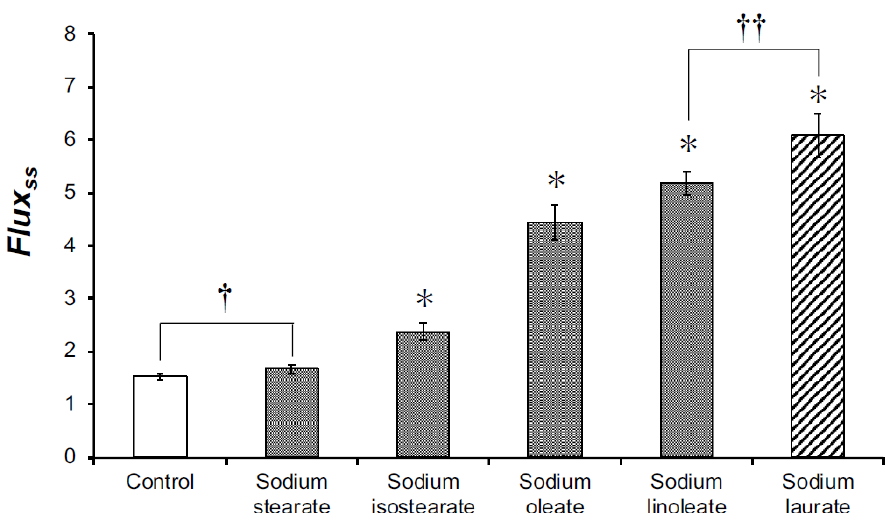
Figure 2. The Fluxss of the skin samples stimulated by each surfactant and control (water). Each point value represents the mean ± standard error, n = 35 (control), n = 6–10 (sample). The white bar represents the Fluxss of the water-treated sample (control). The shaded bar represents the Fluxss of the sodium laurate-treated sample. The Fluxss of each structurally isomeric C18 fatty acid soap (sodium stearate, sodium isostearate, sodium oleate, and sodium linoleate)-treated sample is represented by gray bars and the name of each fatty acid soap is described below the horizontal axis. The measured value, represented by symbol (*), shows the statistically significant di ff erence against the control; p < 0.05. The non-statistically significant di ff erence observed against the control is represented by † and against sodium laurate is represented by †† ; p >